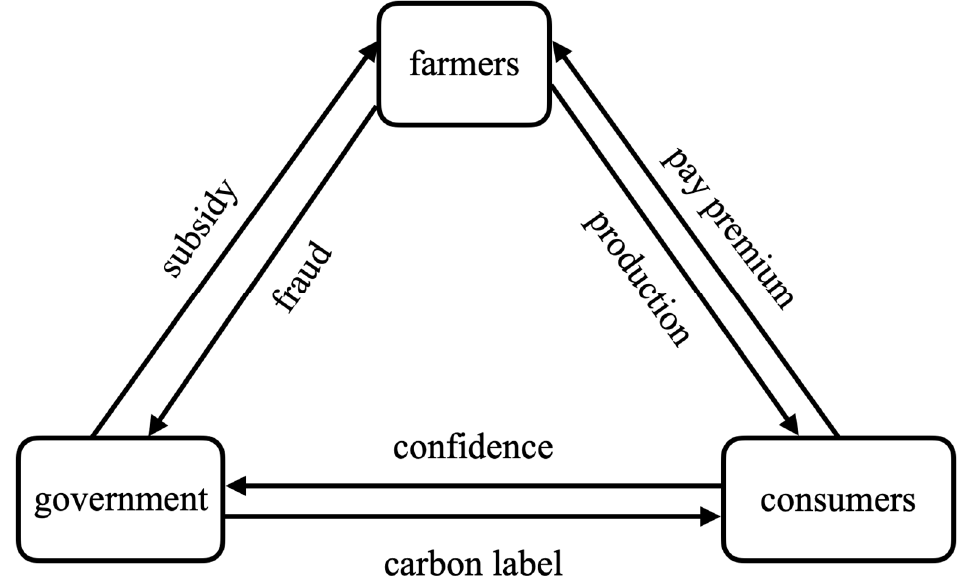
Figure 1. Map of incentives and integration mechanisms for food safety source governance.